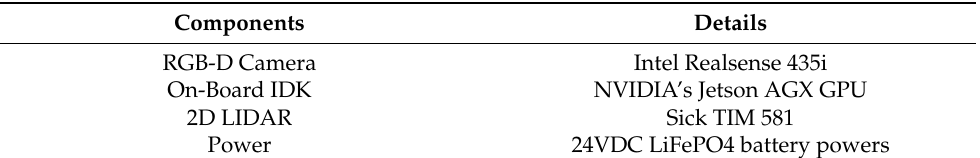
Figure 5. Experiment Robot [3]. Table 4. BELUGA Specification.